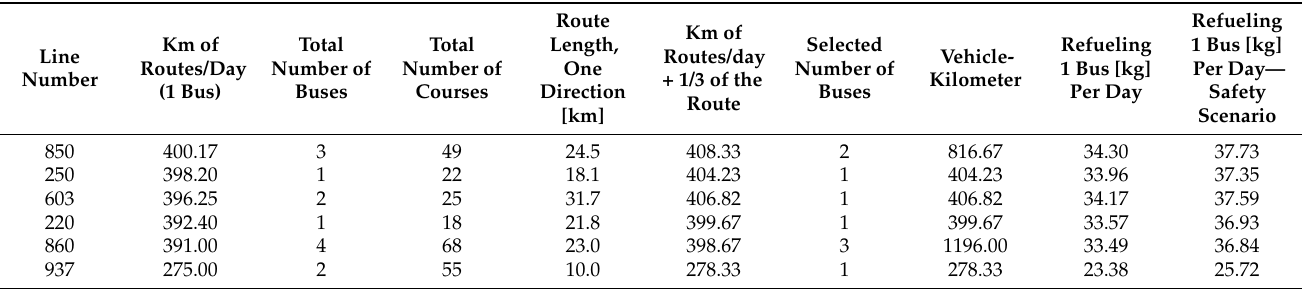
Table 2. A part of the table with detailed data for the selected numbers of bus lines on their courses, routes and refueling—data for working days.